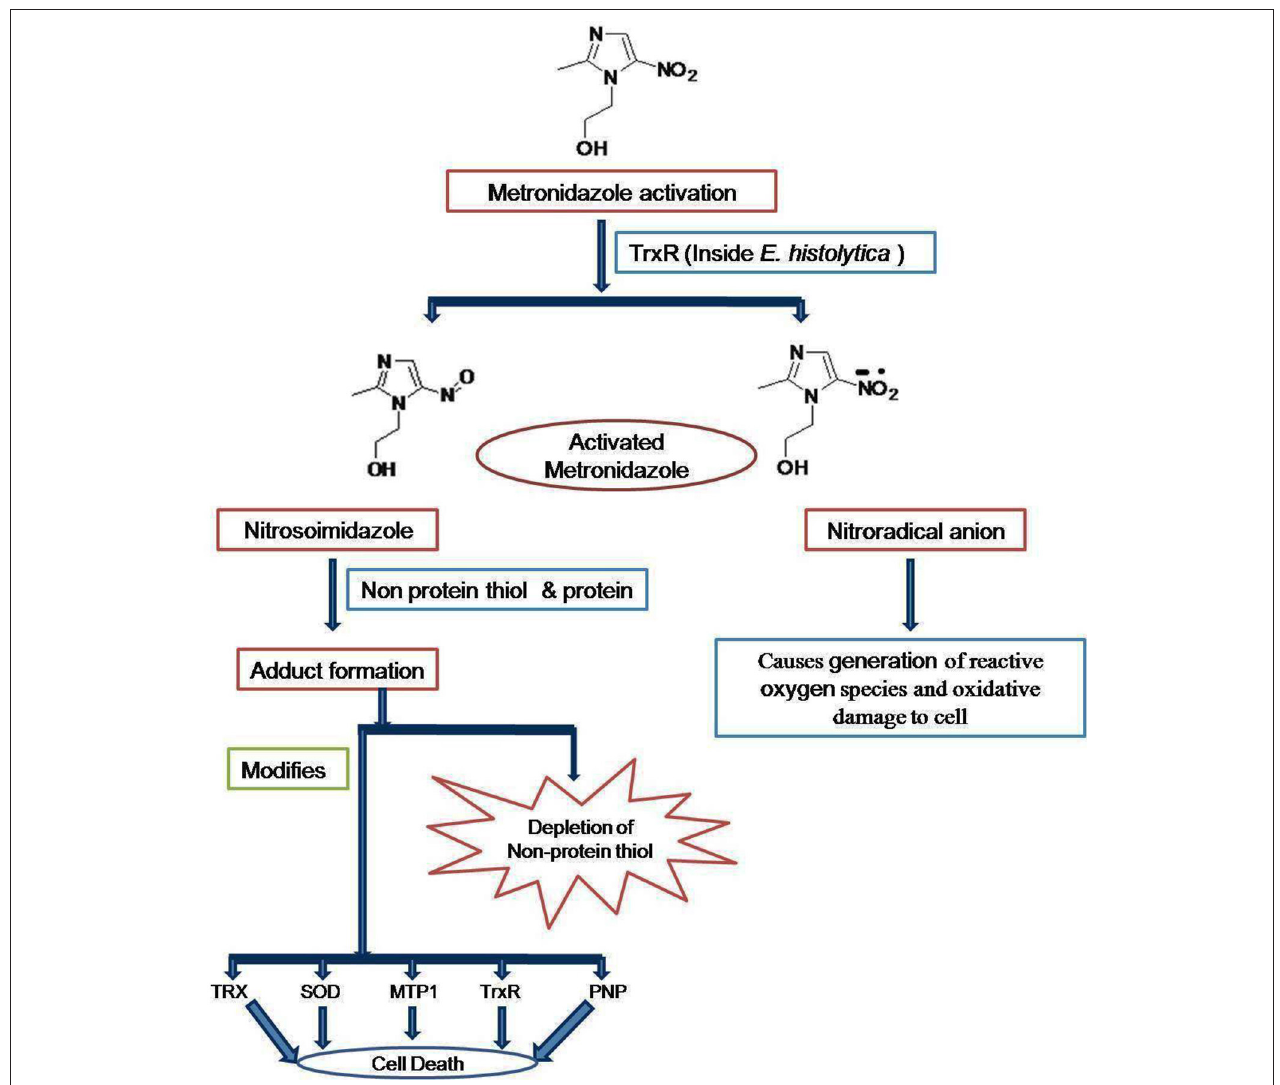
FIGURE 1 | Mode of action of metronidazole in E. histolytica